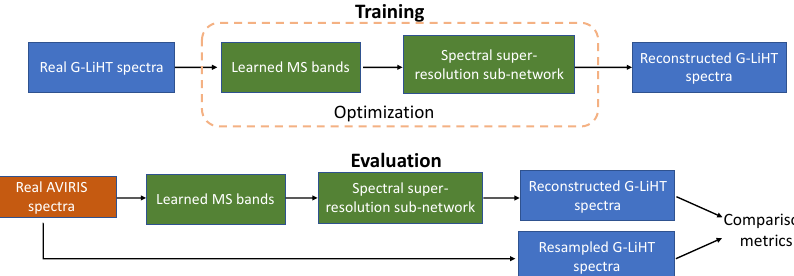
Figure 14. Evaluation of MS bands learned using G-LiHT data on AVIRIS imagery.